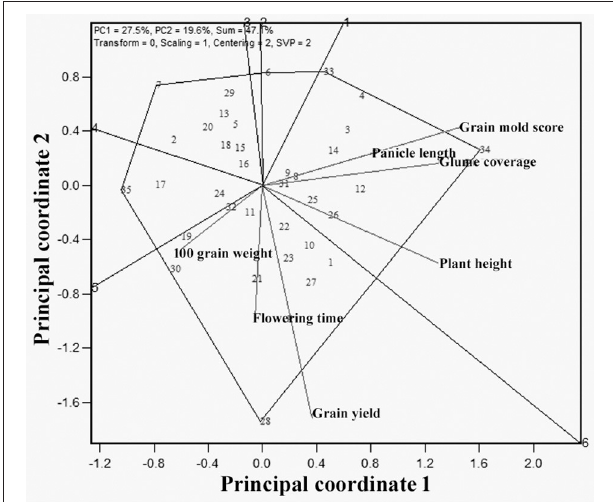
FIGURE 8 | Polygon view of GT biplot indicating which is best for what among the 35 sorghum